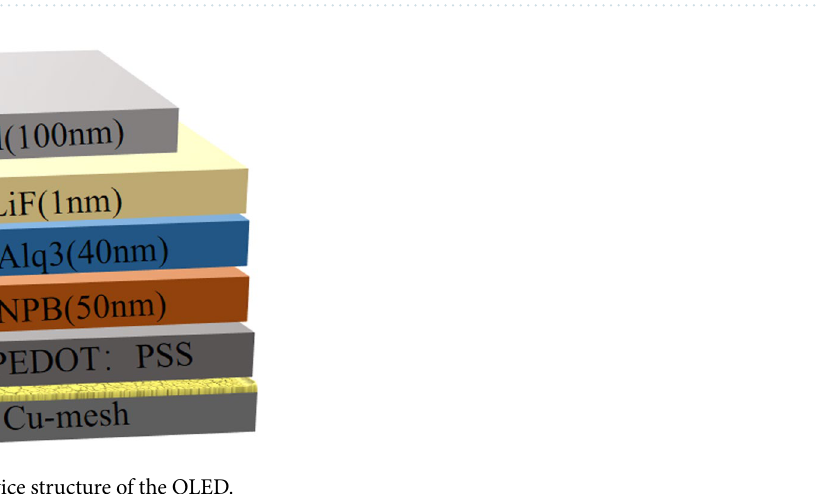
Figure 2. Optical microscope images of crack morphology in different magnification: ( a ) 200 times, ( b ) 500 times.